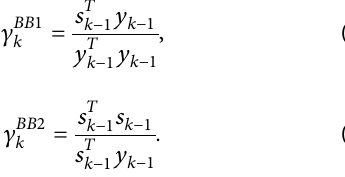
Algorithm 1 from [19] is selected as a framework for implementing the inexact line search which determines the step length α k .